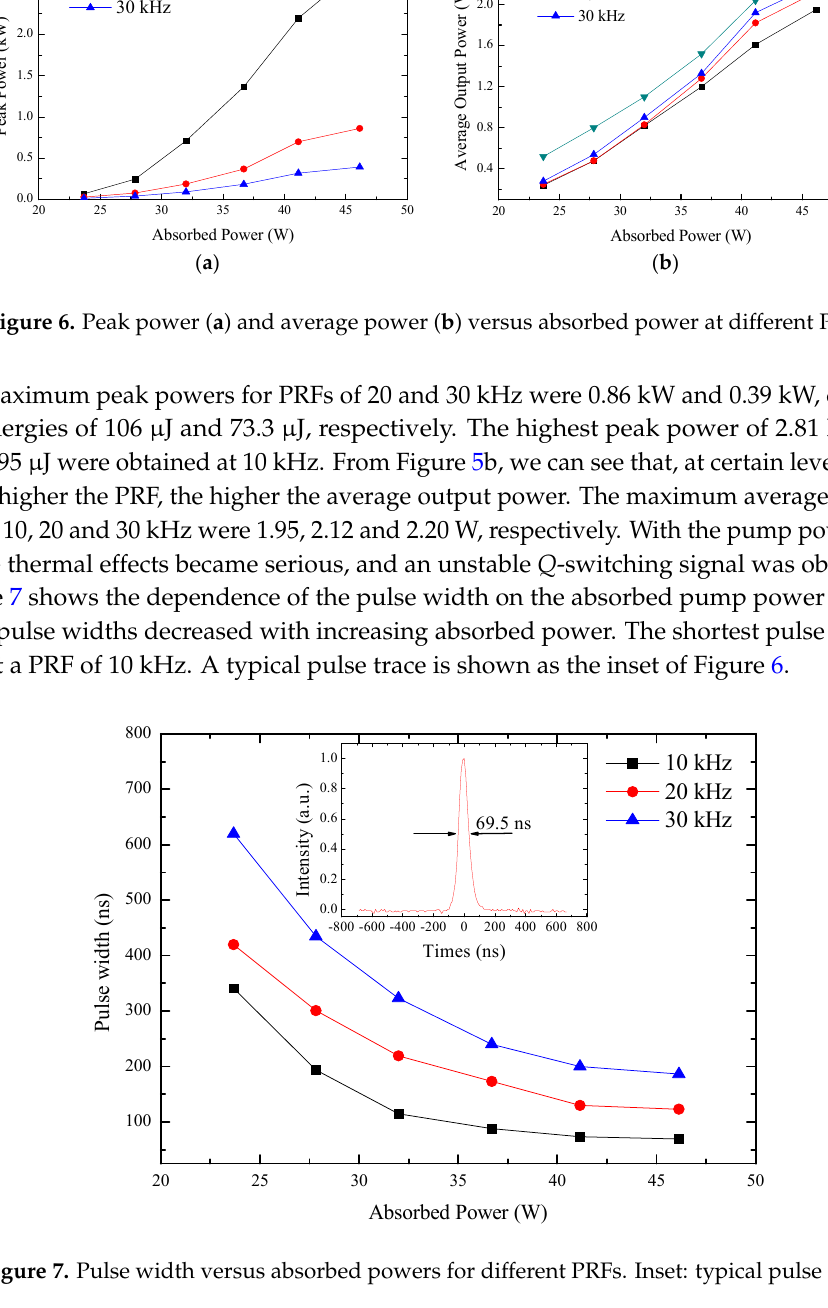
Figure 7. Pulse width versus absorbed powers for different PRFs. Inset: typical pulse trace.